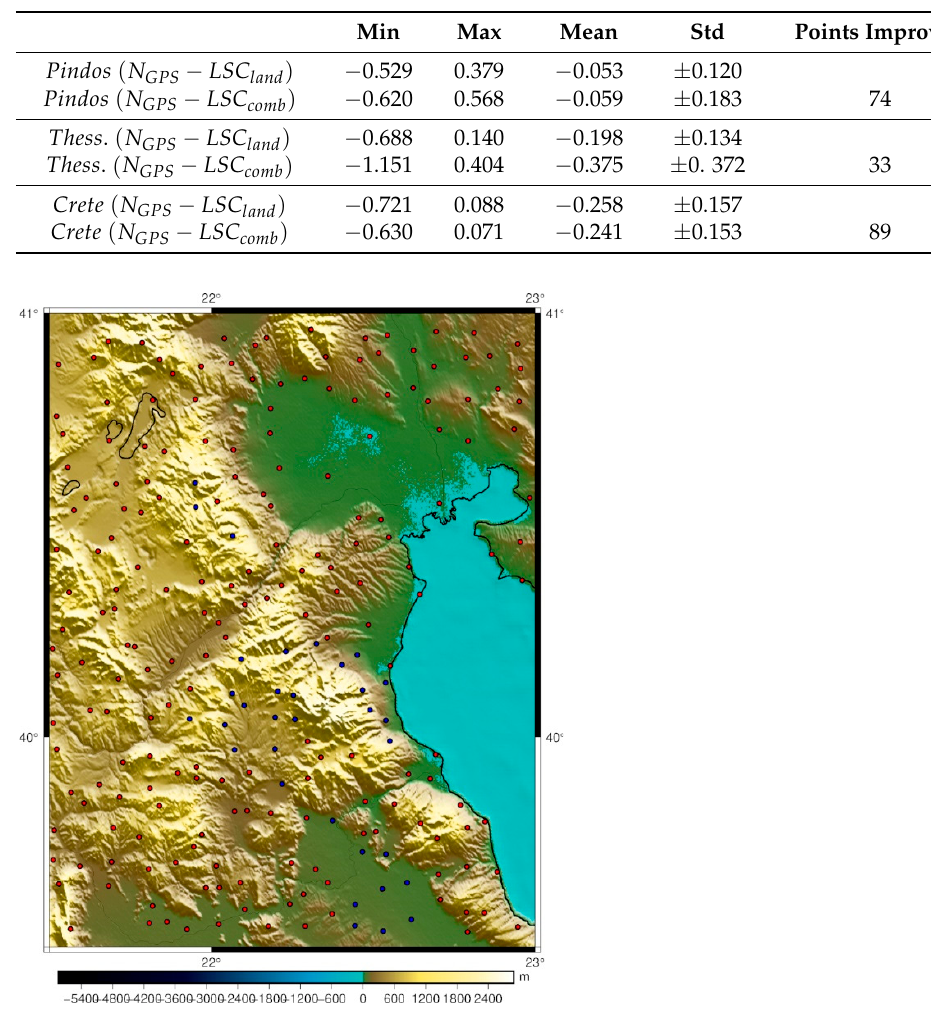
Figure 17. GNSS/levelling BMs over Thessaly with improved differences when using the LSC combined model (blue dots) and BMs where the LSC with land gravity is better (red dots).